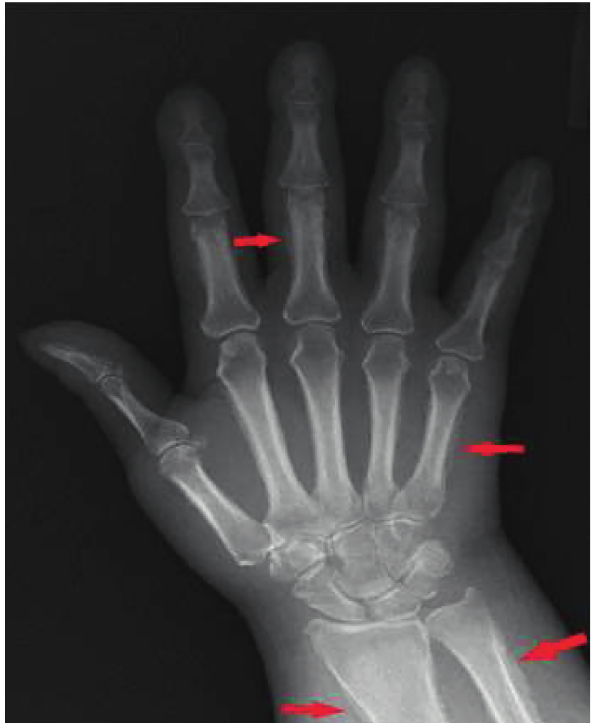
Figure 3: Periosteal thickening involving the metacarpals, prox- imal phalanges, distal radius, and